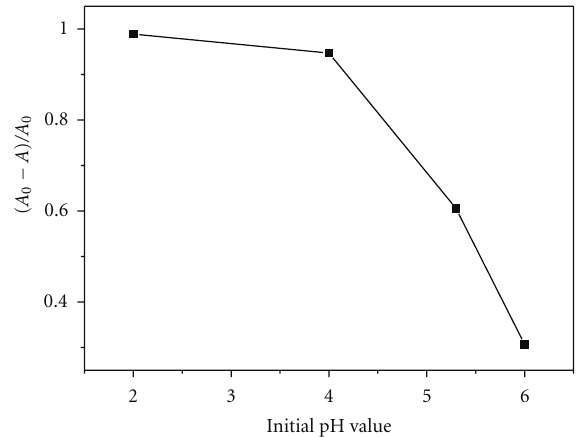
Figure 5: The e ff ect of initial pH value on the degradation e ffi - ciency.